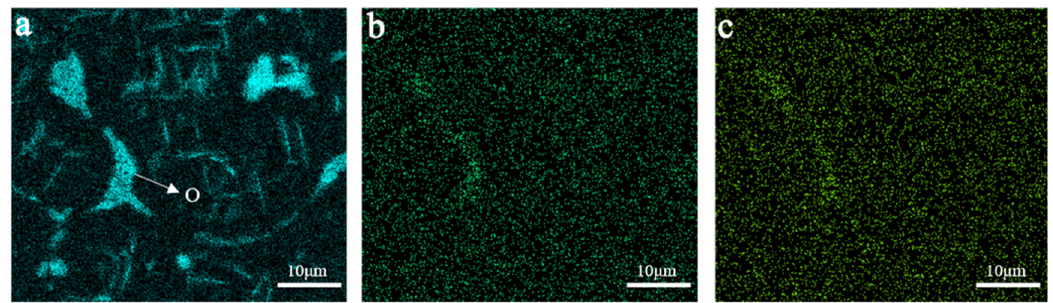
Figure 6. Elemental mapping of the alloy homogenized at 515 °C for 8 h: ( a ) Cu, ( b ) Ce, and ( c ) La elements.